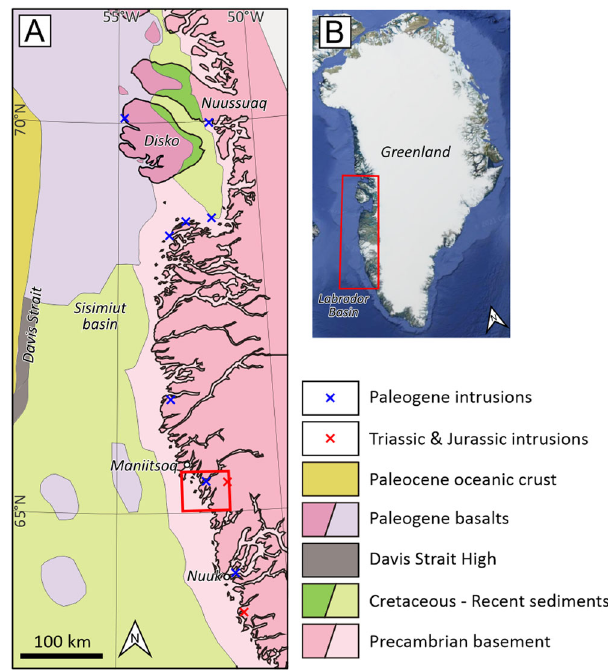
Fig. 1 Location and geology of the study area. A Simpli fi ed geological map of central and southern West Greenland modi fi ed after Oakey and Chalmers 29 and Larsen et al. 26 . Dark and light colours in the legend indicate onshore and offshore occurrences, respectively; red rectangle indicates position of Fig. 2. B Composite satellite image of Greenland with position of part A indicated by red rectangle (map data: Google, IBCAO, Landsat/ Copernicus, SIO, NOAA, U.S. Navy, NGA, GEBCO, U.S. Geological